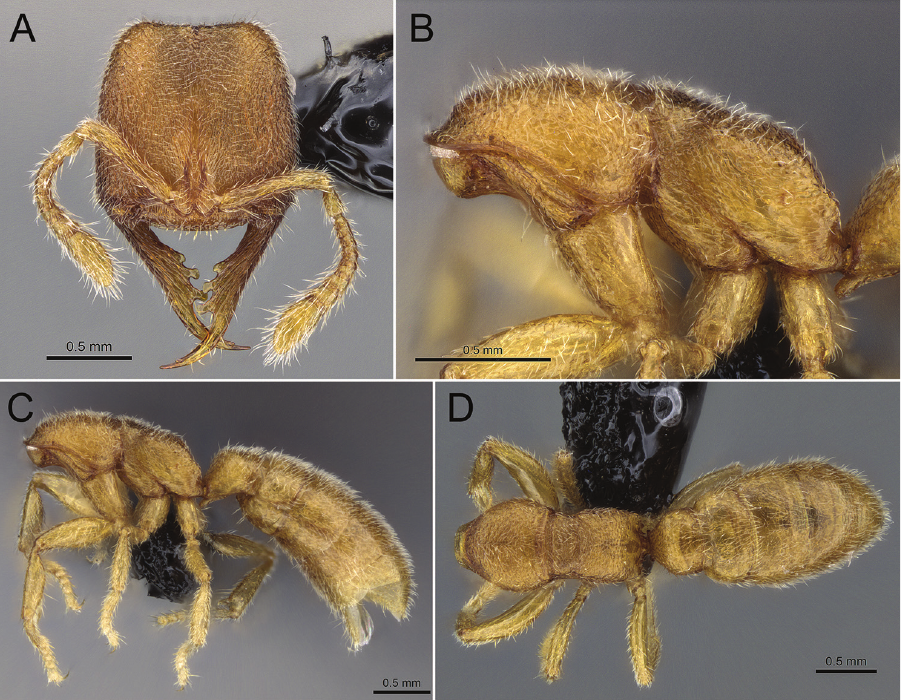
Figure 1. Holotype of Stigmatomma luyiae sp. n. (CASENT0922349); worker. Images by FAE; available at AntWeb.org. A Full-face view B Mesosoma, lateral view C Lateral view D Dorsal